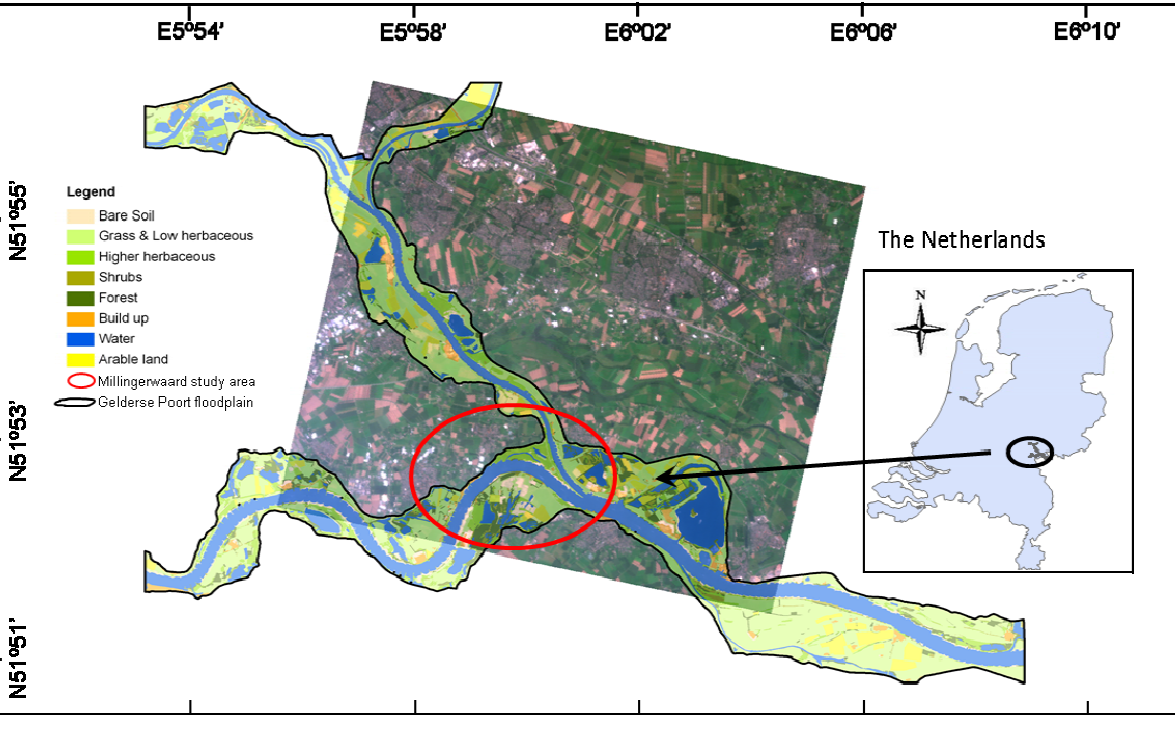
Figure 1. The study area which is located in the east of the Netherlands, indicated on the CHRIS nadir image in true colour band composition (R: 675.2 nm, G: 551.7 nm, B: 490.5 nm). The red circle represents the river floodplains of Millingerwaard. The black outlined river area overlain on the CHRIS nadir image represents the nature reserve the Gelderse